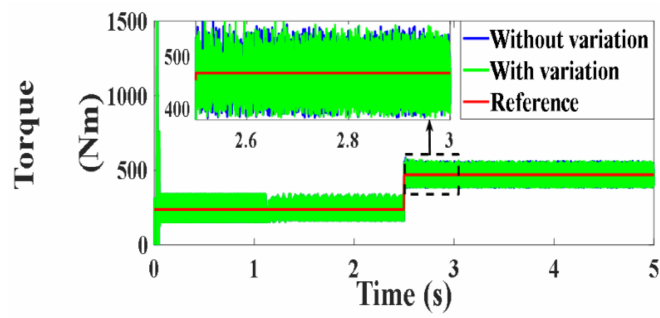
Figure 87. Developed torque under PVC (Nm).